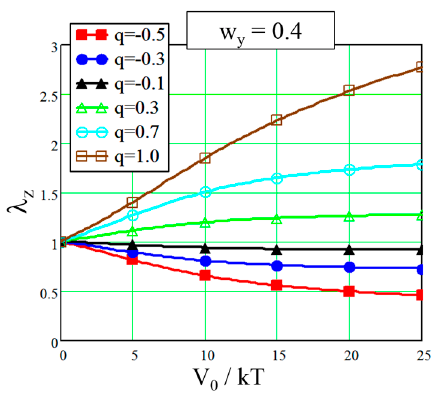
Figure 5. Elongation ratios λ x,y,z as functions of the parameter V 0 /kT at w y = 0.1 ( a ) and w y = 0.4 ( b ) for an azo-network with q = − 1/2.